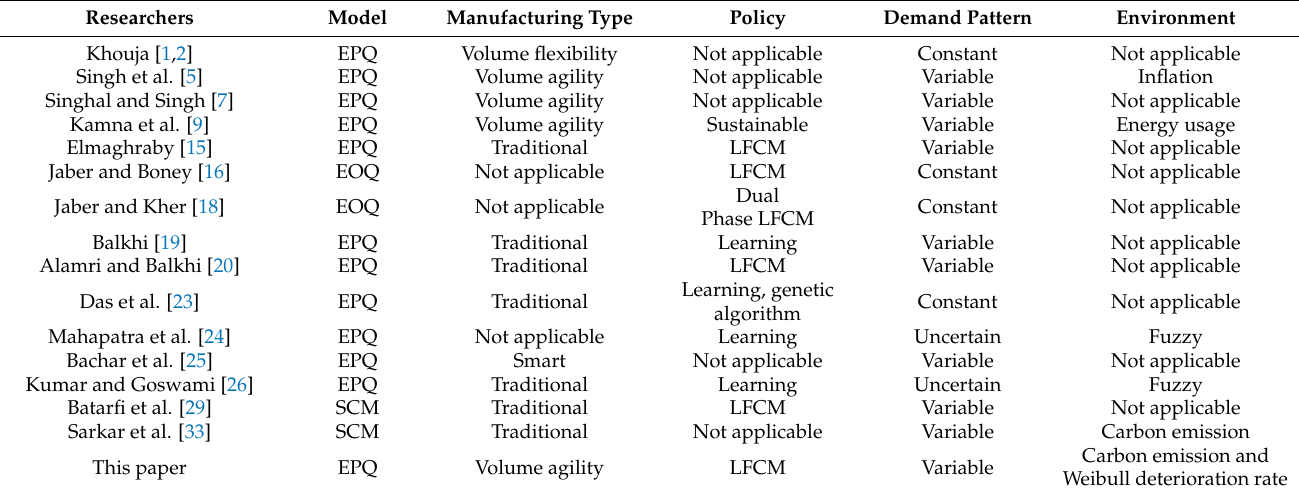
Table 1. Contribution from various